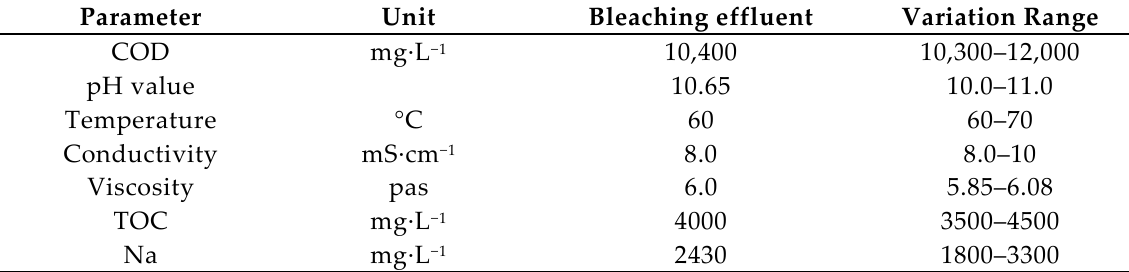
Table 3. Characteristics of the alkaline bleach effluent used in this